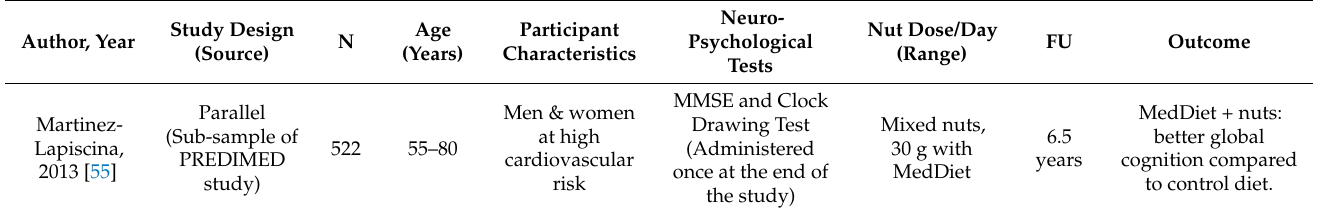
Table 2. Randomized controlled trials of nuts with outcomes on cognitive performance in